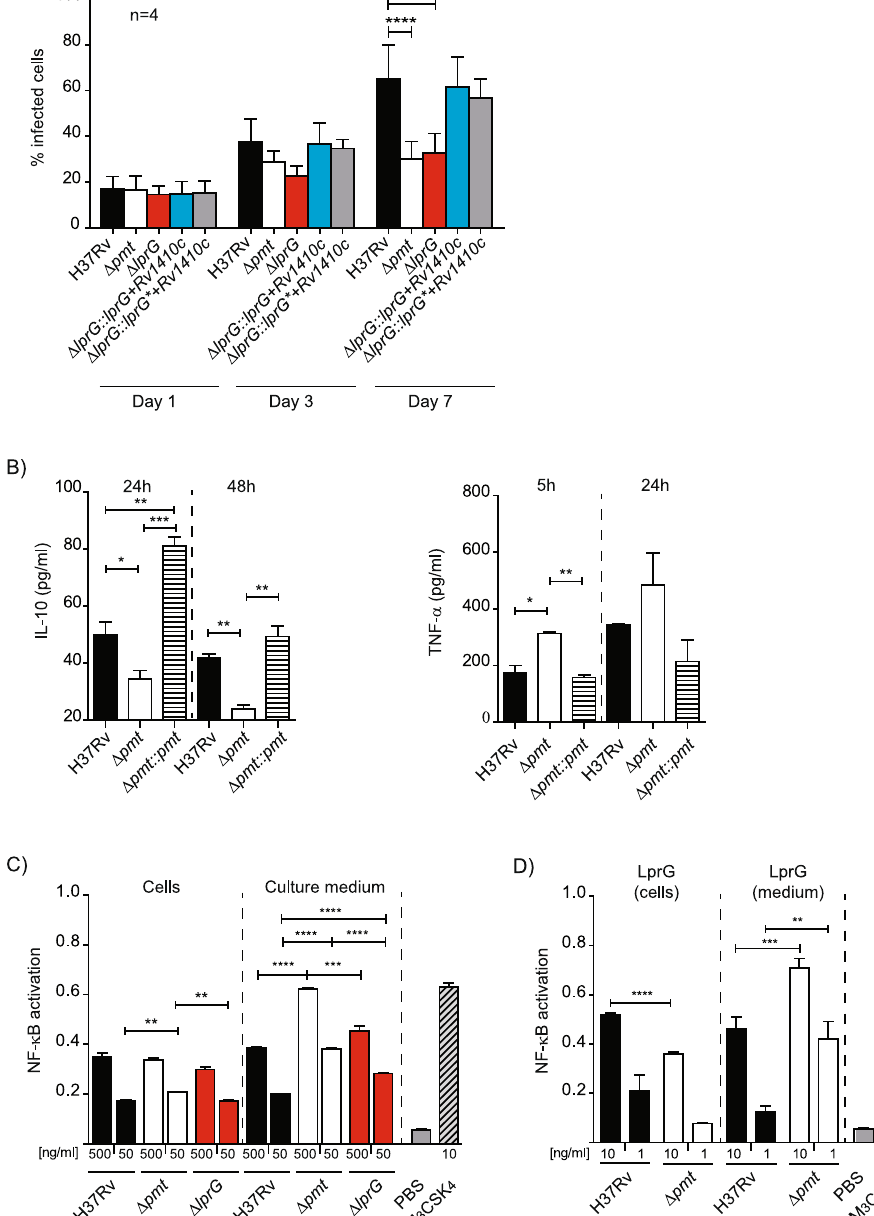
Figure 6. Protein O -mannosylation affects the inflammatory response of infected cells. ( A ) Growth of WT, mutants and complemented strains in hMDM. hMDM were infected at an MOI 1 for 1 h with the indicated strains. Data are presented as the mean + / − SD of four independent experiments performed in duplicate. ( B ) Production of TNF- α and IL-10 by MHS cells infected by WT, Δ pmt and complemented strains. MHS cells were infected at MOI 1:1 for 1 h and TNF- α and IL-10 were evaluated after 5 h or 24 h and 24 or 48 h respectively. Data are representative of two independent experiments performed in triplicate. ( C ) NK- κ B activation in HEK-TLR2 cells incubated with crude extracts from WT and Δ pmt M . tuberculosis strains. Activation of NF- κ B, evaluated using SEAP activity, following incubation with 500 ng/ml or 50 ng/ml of crude extracts recovered from either bacterial cells or culture medium from the indicated M . tuberculosis strains. PBS 1 × or PAM 3 CSK 4 (10 ng/ml) were used as negative and positive controls respectively. Data are presented as the mean + / − SD of three independent experiments. ( D ) NF- κ B activation in HEK-TLR2 cells incubated with LprG/LAM complex purified from bacterial cells or culture medium of WT or Δ pmt M . tuberculosis strains. HEK-TLR2 cells were incubated with 10 ng/ml or 1 ng/ml of LprG-His and co-purified LAM. SEAP activity was quantified after 24 h. PBS 1 × or PAM 3 CSK 4 (10 ng/ml) were used as negative and positive controls respectively. Data are presented as the mean + / − SD of at least five independent experiments. * P < 0.05; ** P < 0.01; *** P < 0.001; **** P <